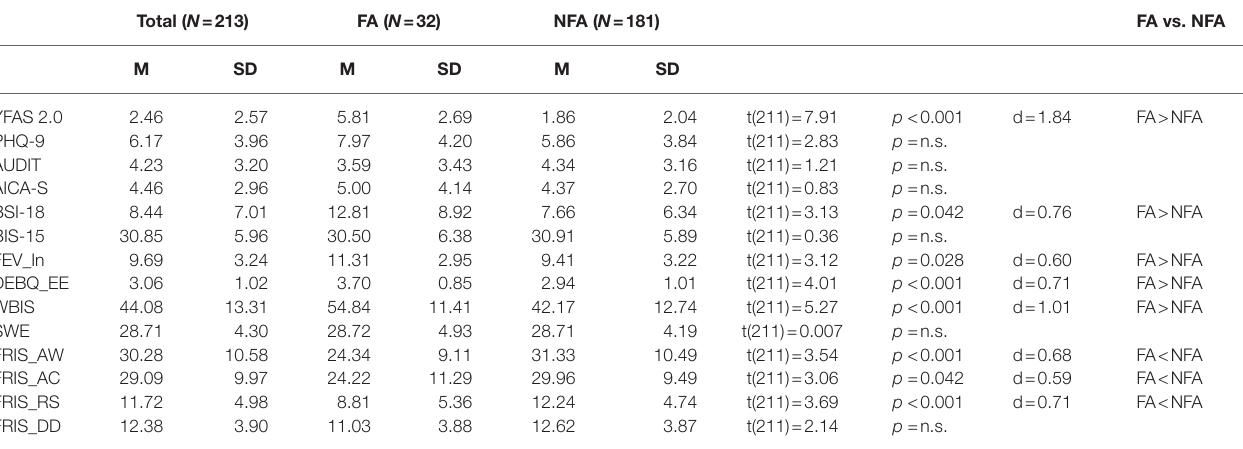
TABLE 4 | Psychopathology and weight- and addiction-related constructs (FA vs. NFA). Total ( N = 213) FA ( N = 32) NFA ( N = 181) FA vs. NFA M SD M SD